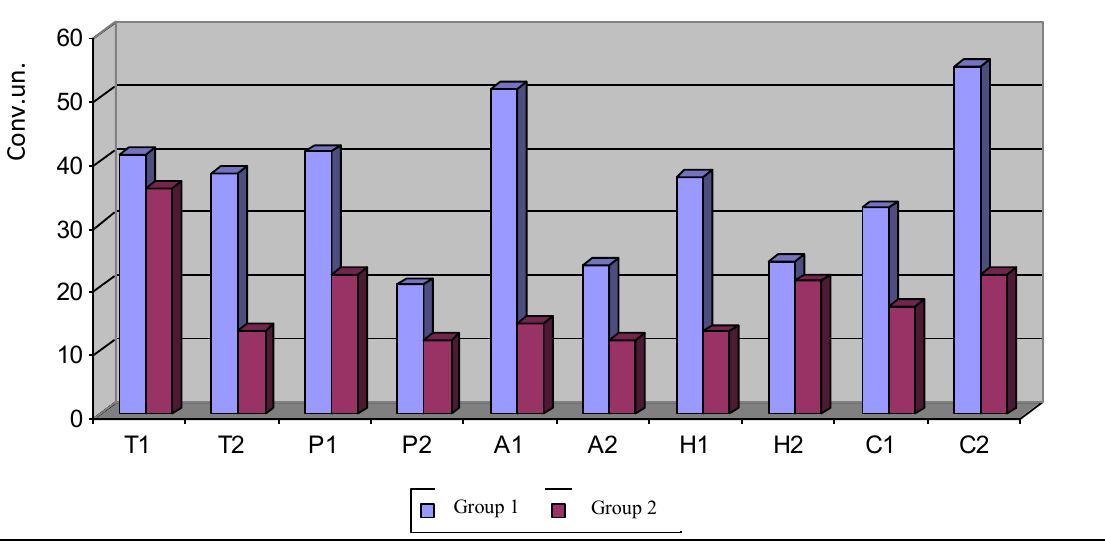
Fig.1. Dynamic of system’s formation indicators of